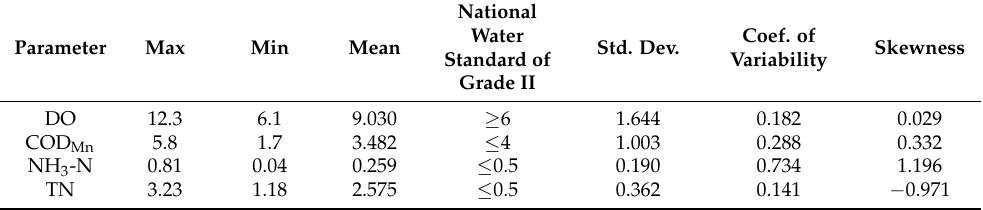
Table 5. Statistical description of downstream water quality indicators (concentration units in